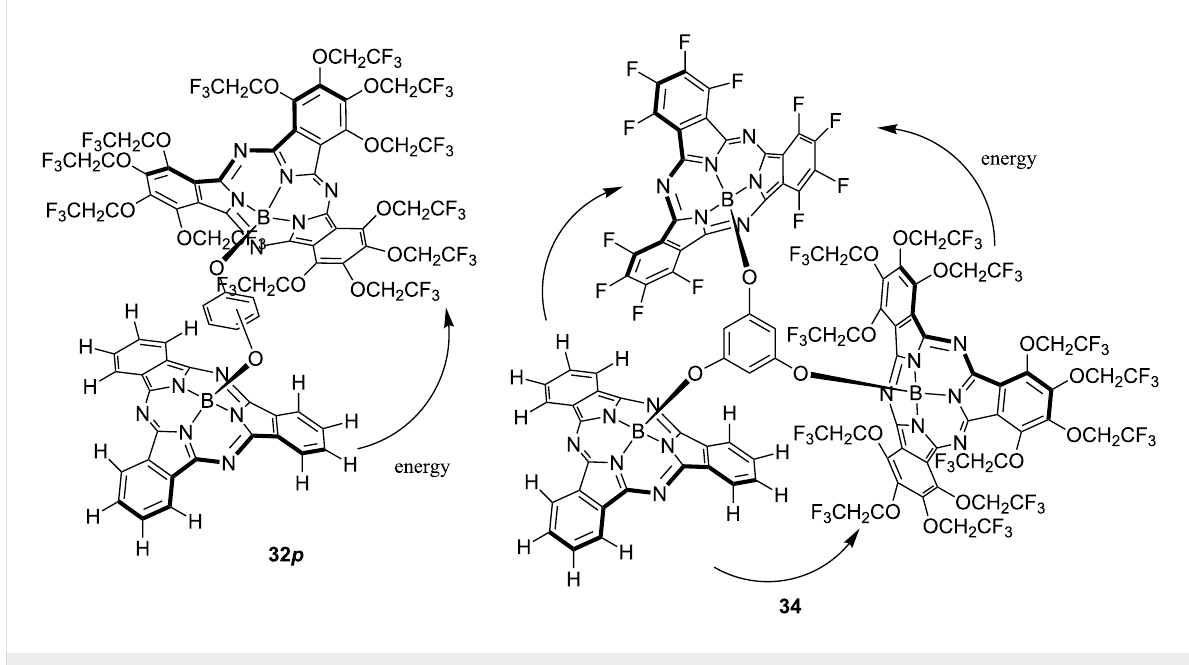
Figure 8: Energy transfer between subphthalocyanine units.